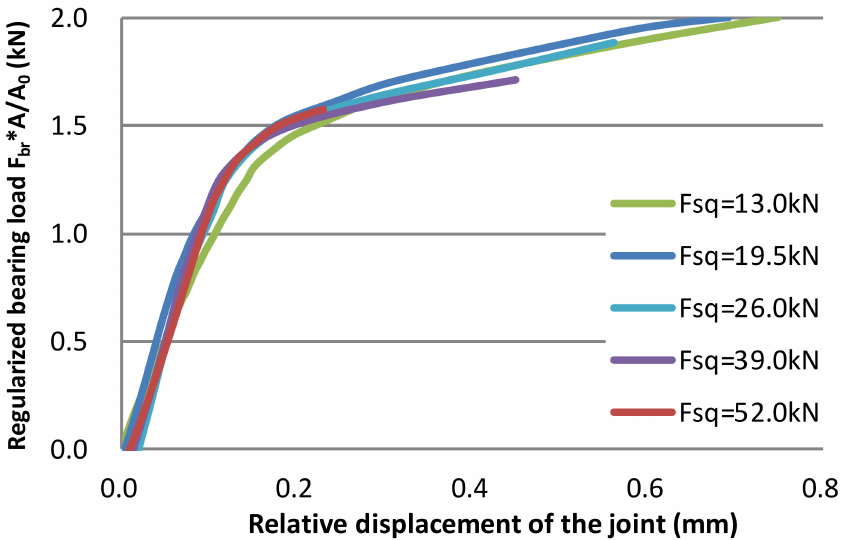
Figure 13. Regularization of the curves of bearing load by the cross-sectional area of rivet